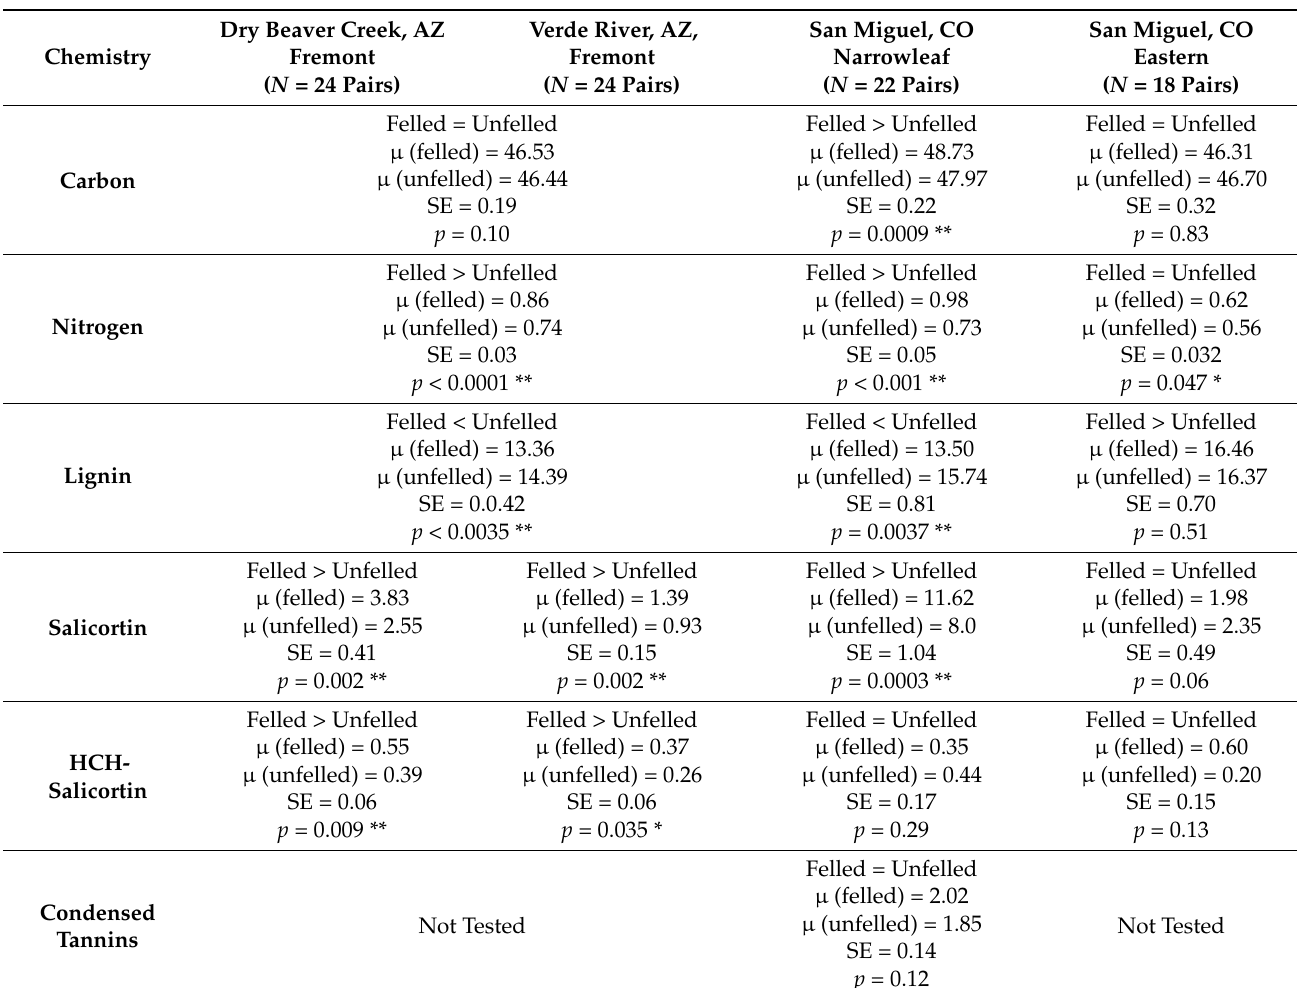
Table 1. Chemistry composition was significantly different in twigs collected from juvenile resprout growth than in juvenile twigs from unfelled trees in Arizona and in Colorado. When we analyzed each chemical independently, we found no significant difference between Arizona sites for carbon, lignin or nitrogen, so these sites were pooled for analyses. The directionality of each difference, if any, along with the corresponding p -value is reported. All analyses were conducted using a non-parametric Wilcoxon-Signed Rank Test, and Bonferroni adjusted for an α of 0.007 for Fremont and Eastern cottonwood and 0.008 for narrowleaf cottonwood. p -values with two asterisks ** are significant with Bonferroni-adjusted α . p -values with one asterisk * are significant prior to Bonferroni adjustments. In Fremont cottonwood, we found significant differences in 5 out of 7 analyses when using Bonferroni adjustments and in 6 out of 7 analyses without Bonferroni adjustments. In narrowleaf cottonwood, we found significant differences in 4 out of 6 analyses both with and without Bonferroni adjustments. In Eastern cottonwood, we found a significant difference in 1 out of 5 analyses (nitrogen), but significance was not maintained with Bonferroni